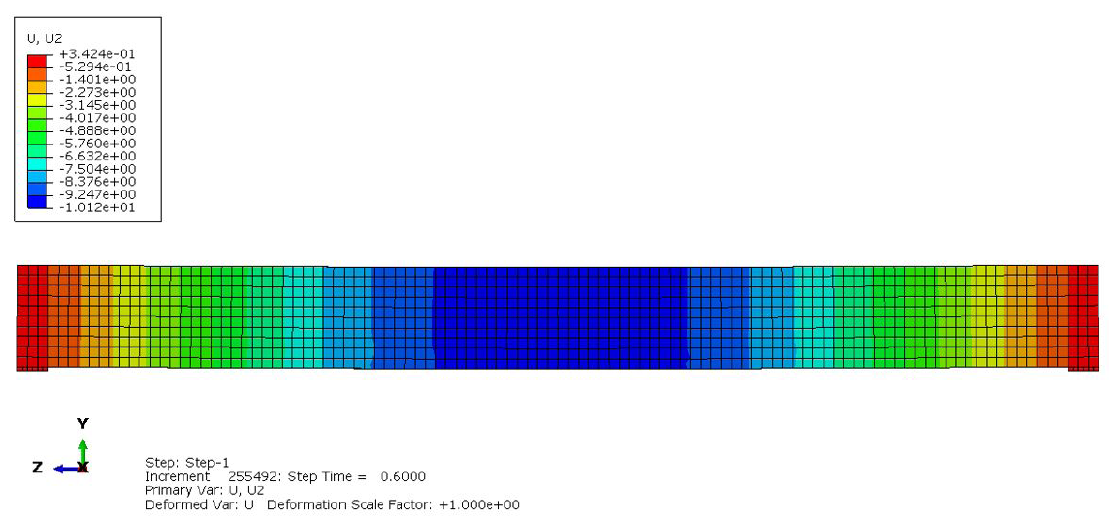
Figure 18: Beam deflection under load of 40 kN/m (deflection values in